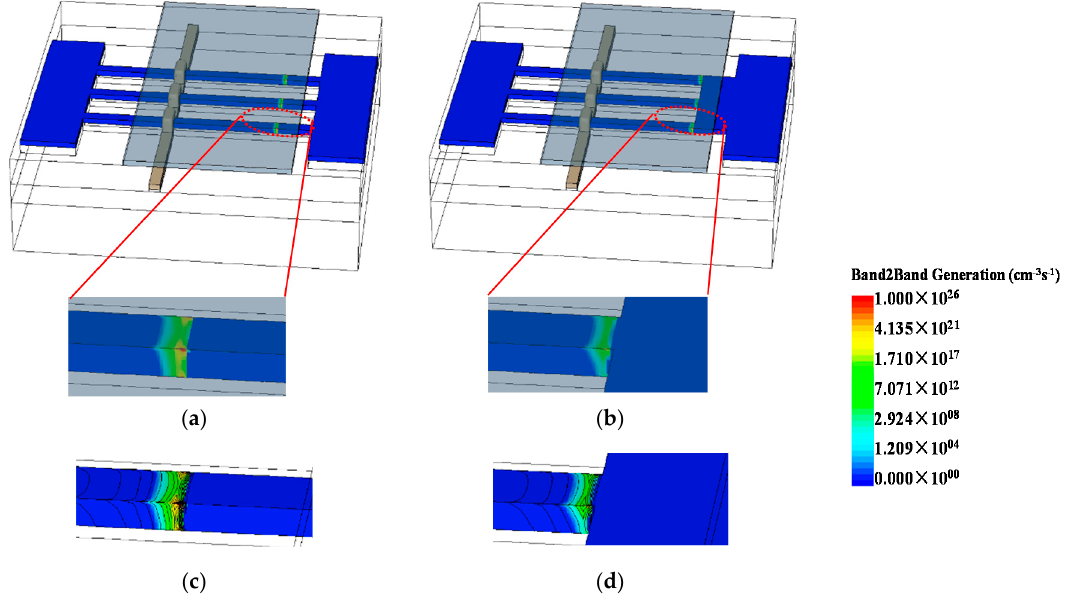
Figure 9. BTBT-GR of W200 with ( a ) L EX = 0 μ m and ( b ) L EX = 0.6 μ m and 3-D profile with electric field contours for ( c ) L EX = 0 μ m and ( d ) L EX = 0.6 μ m.